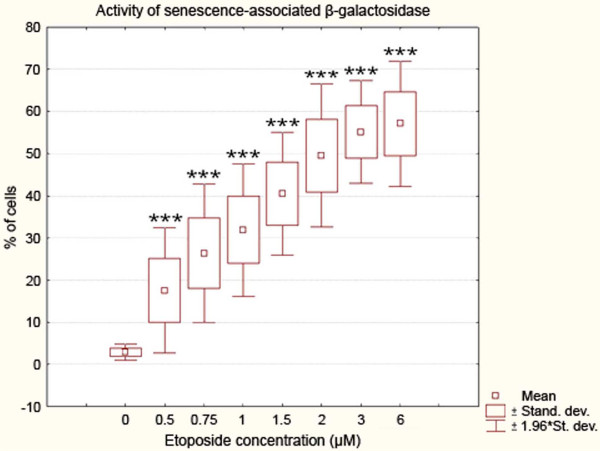
Activity of senescence-associated ß-galactosidase in A549 cells after treatment with etoposide - statistical data from light microscopic examinations. Incubation with increasing concentrations of the drug (0.5, 0.75, 1, 1.5, 2, 3 and 6 μM etoposide) for 72 h was followed by further 24 h of incubation in fresh medium. The activity of the enzyme was detected at pH 6. Very highly statistically significant differences as compared to the control cells are marked by asterisks (Cochran–Cox statistics, P<0.001). Results are representative of ten independent experiments.